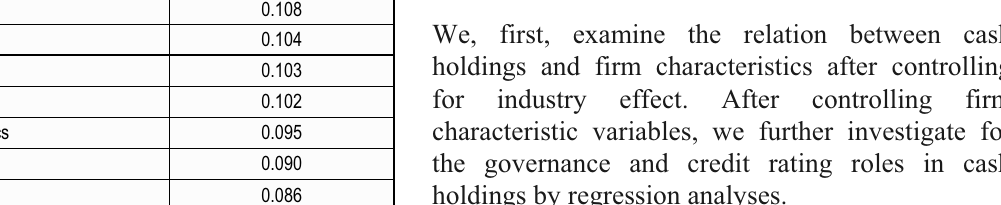
Table 5. Multivariate analysis of cash holdings and corporate